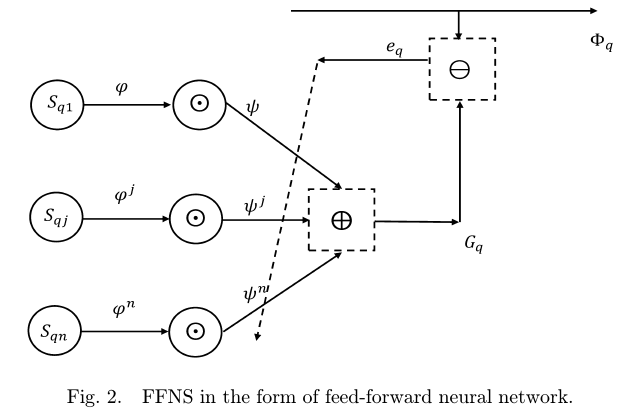
Fig. 2. FFNS in the form of feed-forward neural